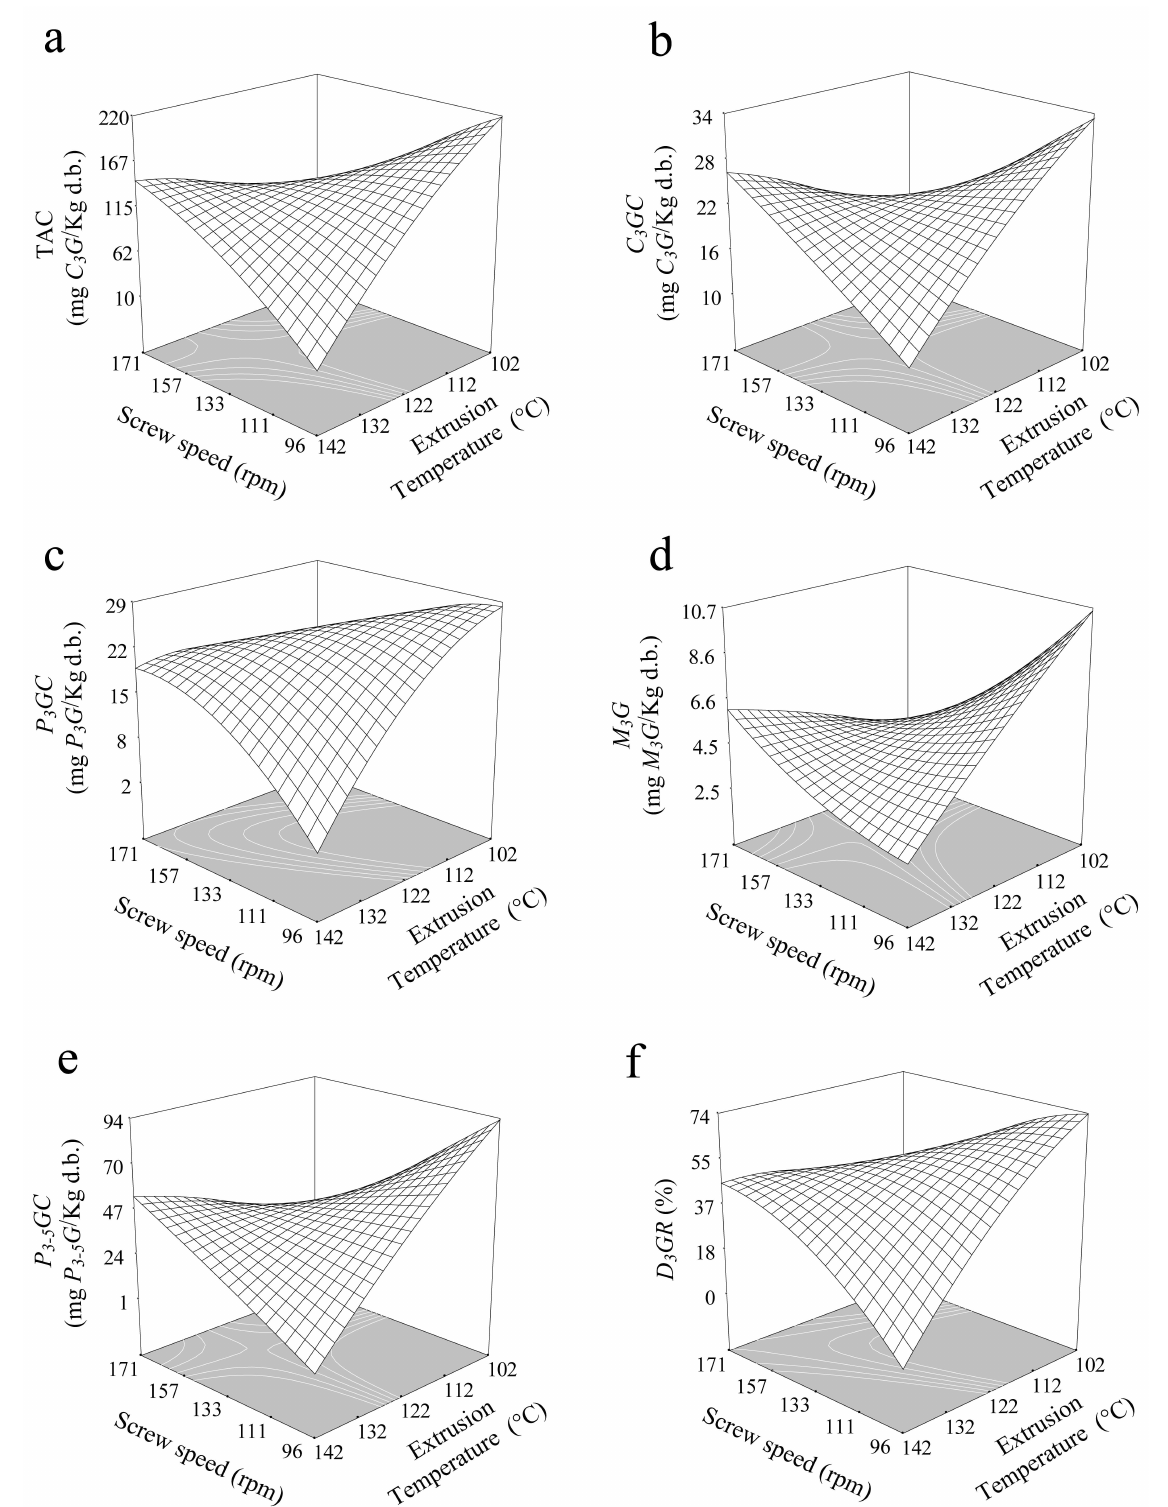
Figure 1. Effect of screw speed and extrusion temperature: ( a ) TAC = Total anthocyanin content, ( b ) C 3 GC = cyanidin- 3-glucoside content, ( c ) P 3 GC = pelargonidin 3-glucoside content, ( d ) M 3 GC = malvidin 3-glucoside content , ( e ) P 3-5 DGC = pelargonidin 3-5-diglucoside content and ( f ) D 3 GR = retention percentage of delphinidin 3-glucoside chloride in